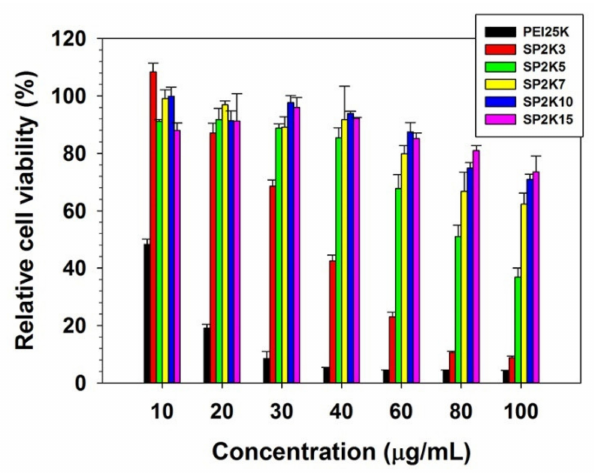
Figure 5. MTT assay result of SP2K polymers in HeLa cells. Error bars indicate the standard deviations ( n =